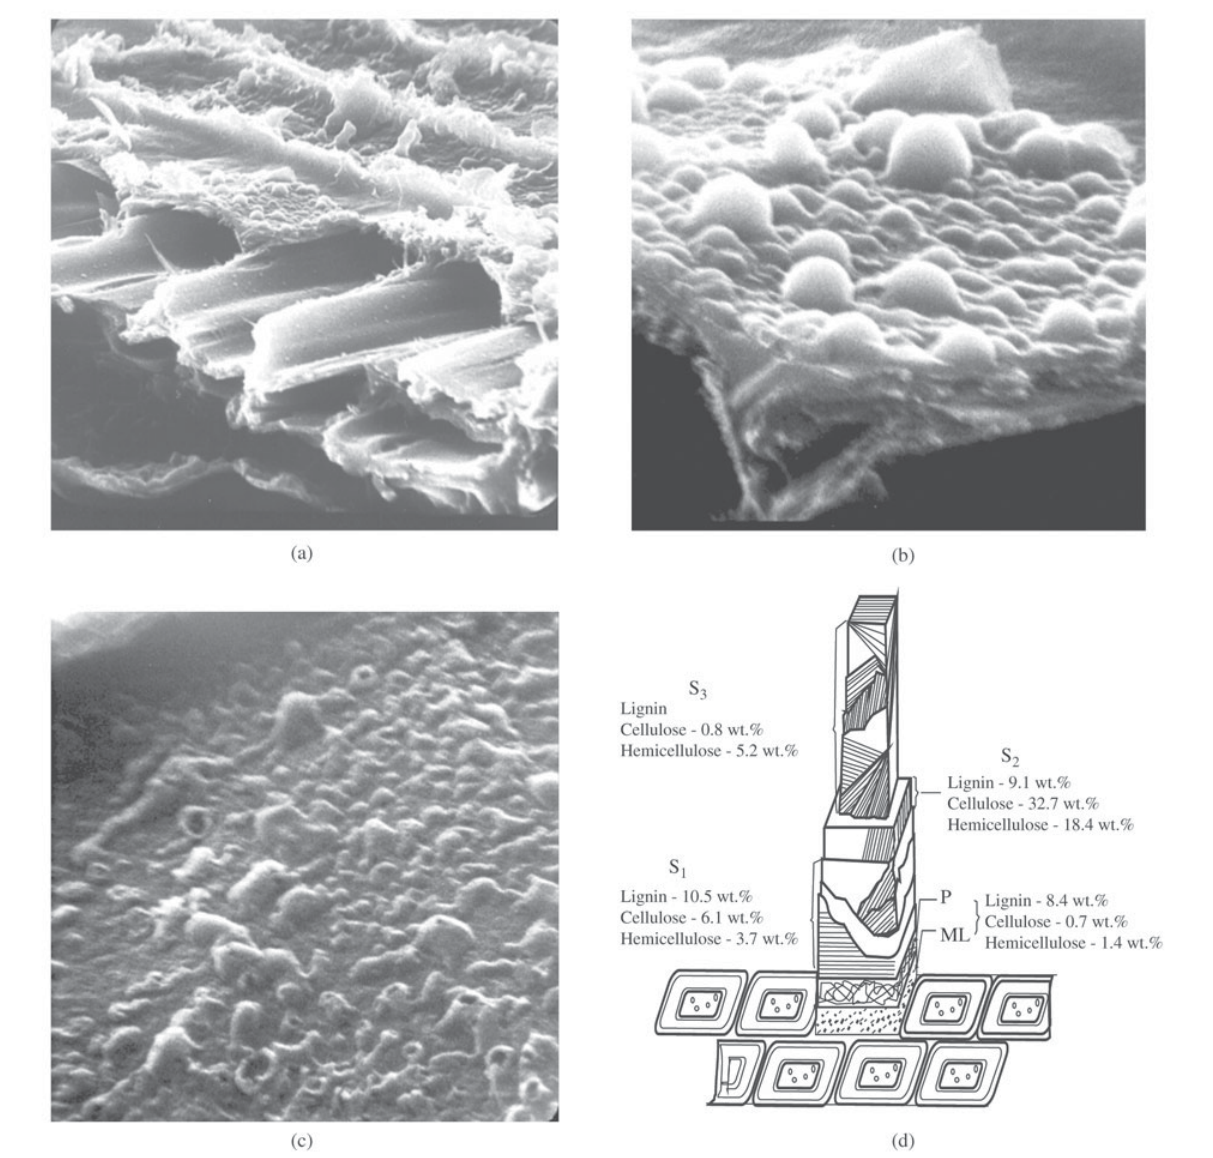
lamella; c) microvolcanoes at the internal wall of the cytoplasm; d) structure of the cellular